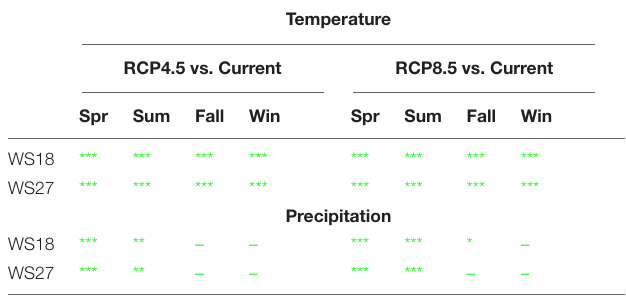
TABLE 1A | Seasonal temperature and precipitation in the past, current, and future (RCP4.5 and RCP8.5) conditions at WS18 and WS27. Spr Sum Fall Win Mean Differ. 2 Var. 3